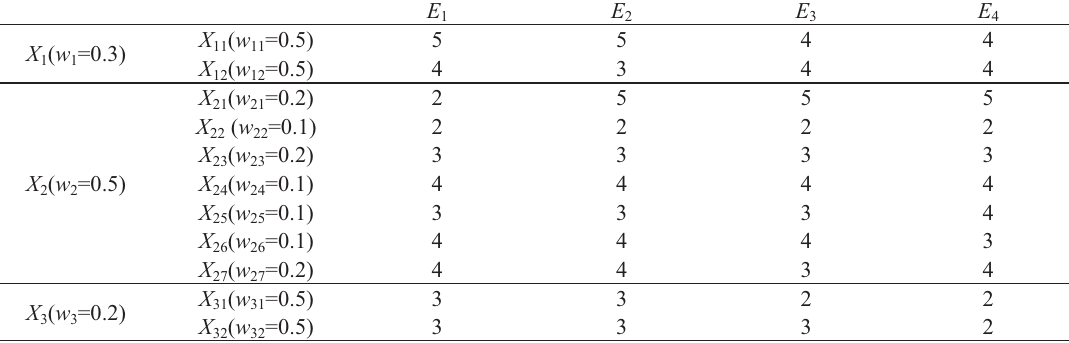
Table 7. The group decision matrix R 2 for Hubin commerce & tourism district using NVs